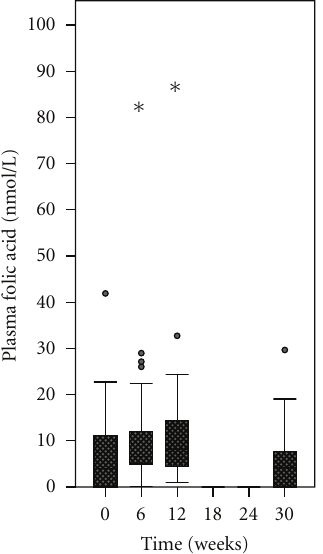
Figure 9: Plasma concentrations of unmetabolized folic acid among women who supplemented with either 1.1mg or 5mg of folic acid (all participants combined). When pooled data from both groups were analyzed, there was a significant change in plasma folic acid concentrations ( P = 0 . 019). ( ∗ ) There was a significant decline from week 12 to week 30 ( P < 0 .